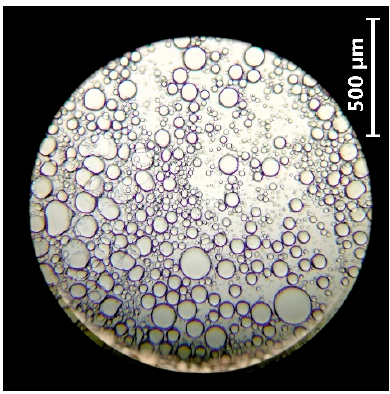
Figure 3. Microscopic image of freshly prepared oil droplets in the alginate-oil emulsion at a magnification of 10×.